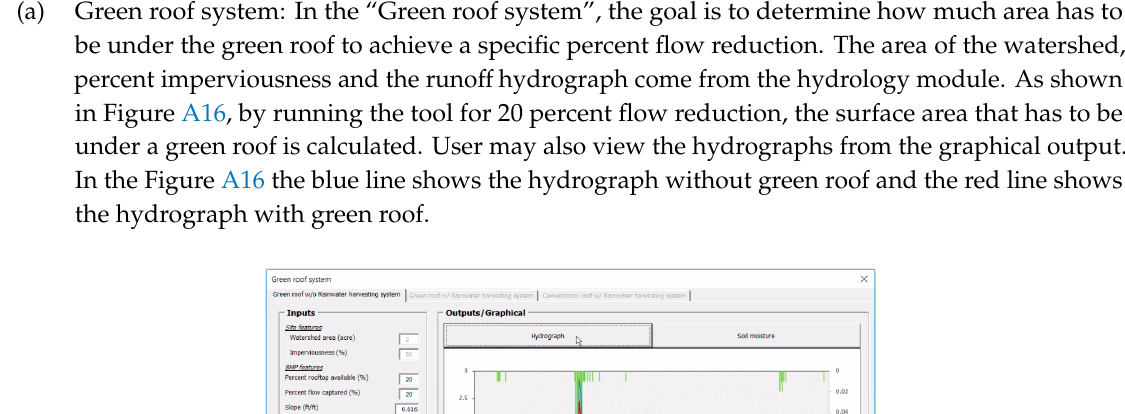
Figure A15. BMP sizing module.